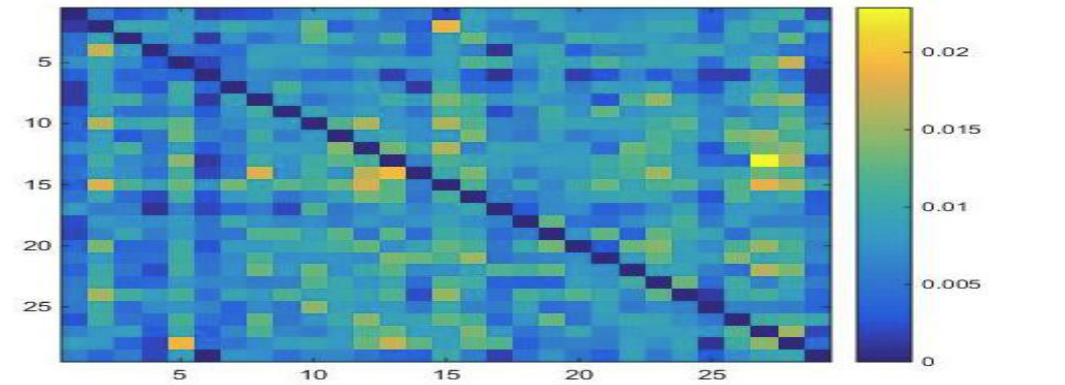
Figure 1. Adjacency matrix obtained from the transition entropy in the US Dow Jones group with 30 companies